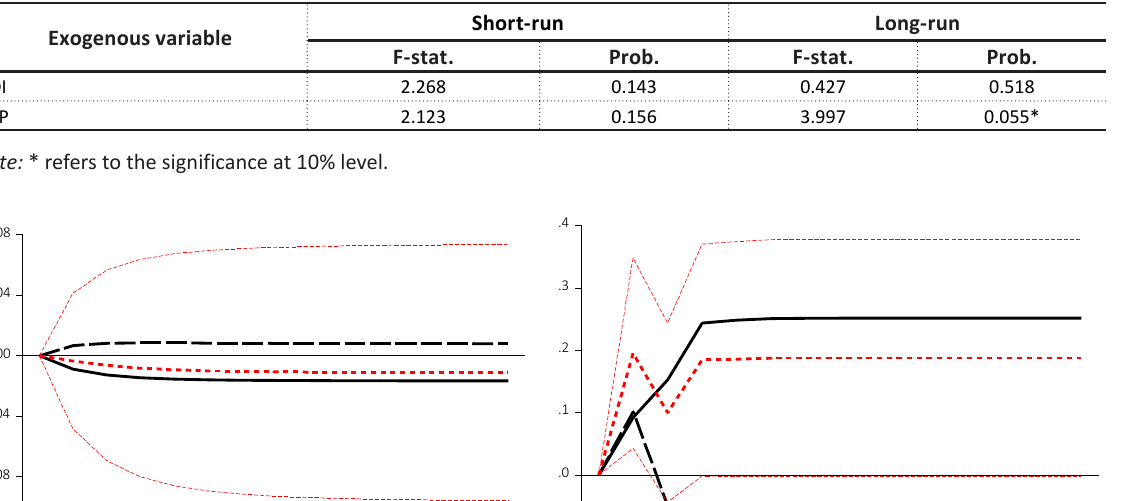
Table 8. NARDL Wald test